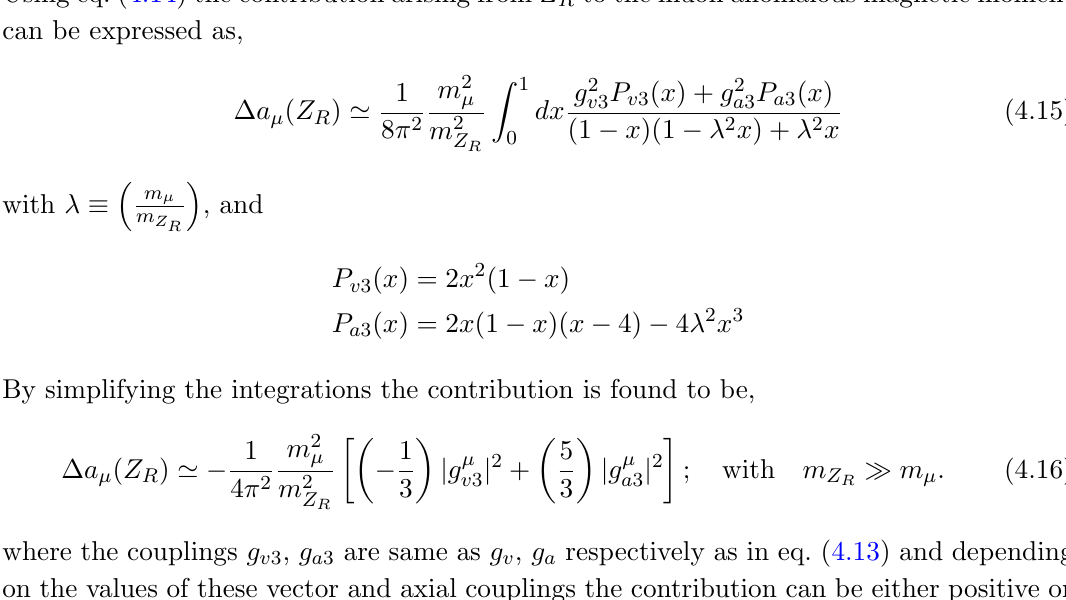
Figure 2 . Feynman diagram for muon anomalous g right-handed neutral gauge boson Z R with